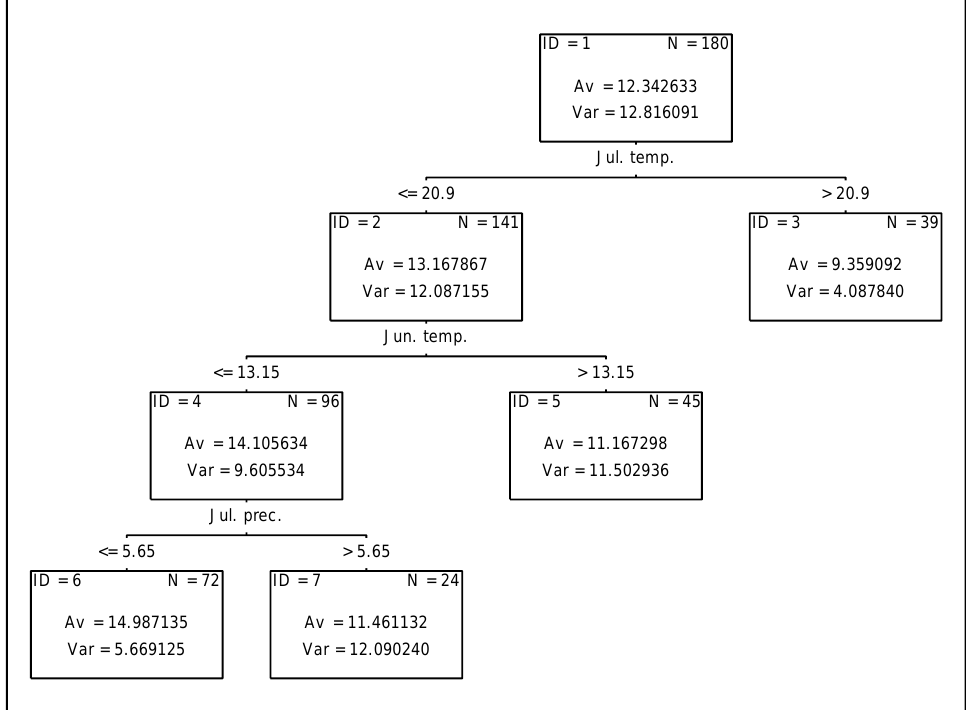
Figure 8. Diagram of regression tree reflecting nitrogen acquisition from fertiliser by soybean plants treated with Asahi.